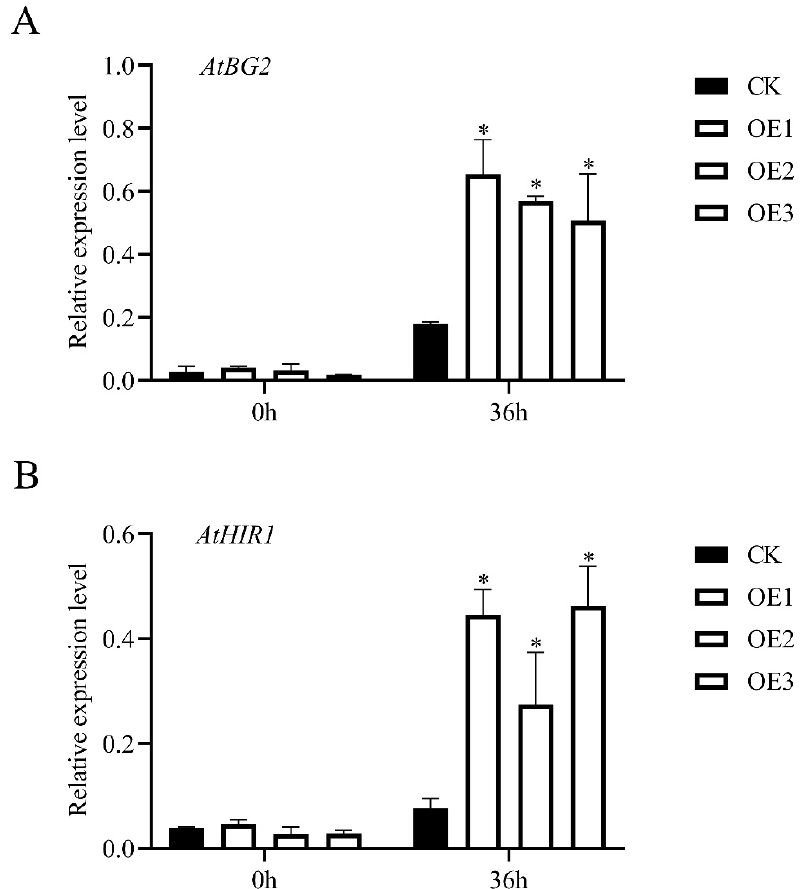
Figure 6. Relative expression of pathogen-related genes in the empty vector transgenic (CK) and MnChi18 transgenic (OE) Arabidopsis leaves before and after of B. cinerea inoculation. ( A ) AtBG2 relative expression levels; ( B ) AtHIR1 relative expression levels. Error bars indicate the standard deviation, n = 3; * p -value < 0.05.